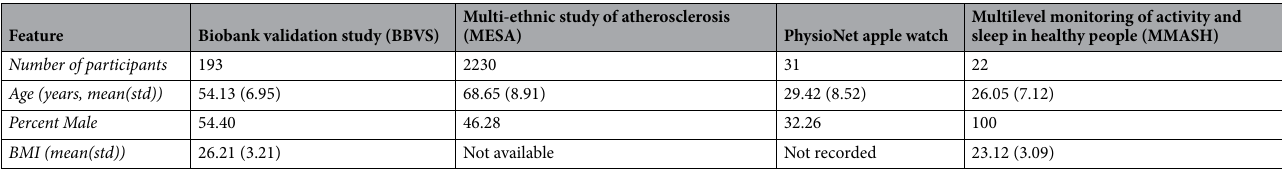
Table 2. Summary of data set